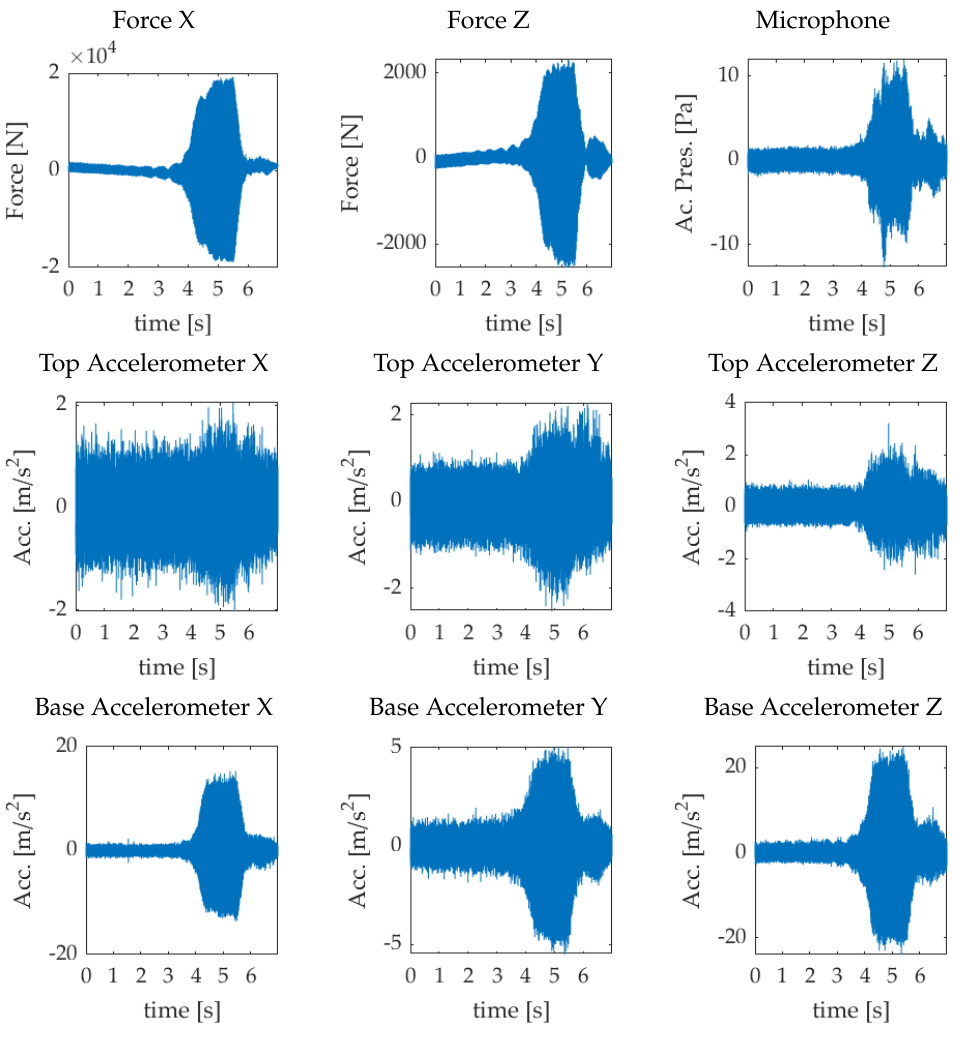
Figure 14. Signals acquired in Case